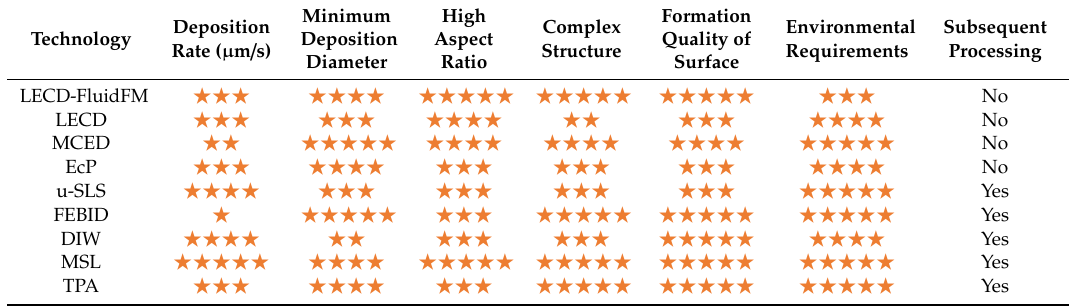
The rows in Table 1 represent technology, and the columns represent technical characteristics. The number of stars represents how dependent the technology is on this parameter. (cid:70)(cid:70)(cid:70)(cid:70)(cid:70) means that the technology is very dependent on this parameter, and (cid:70) means that the technology is less dependent on this